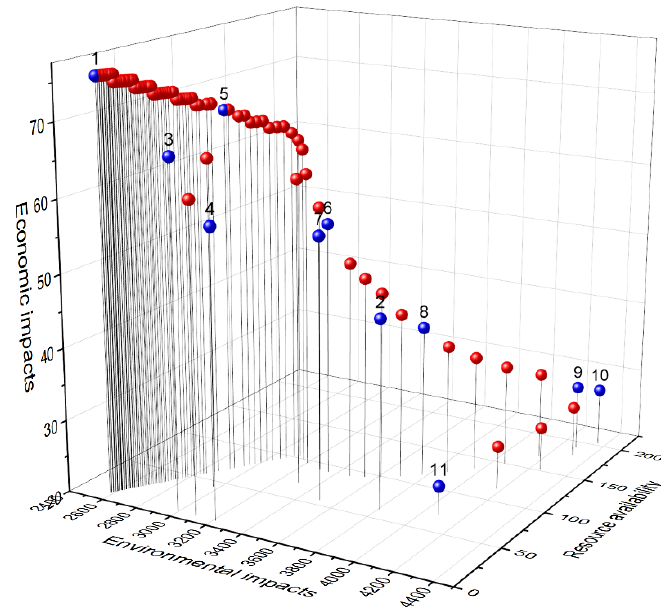
Figure 2. Optimal mixes in Finland.